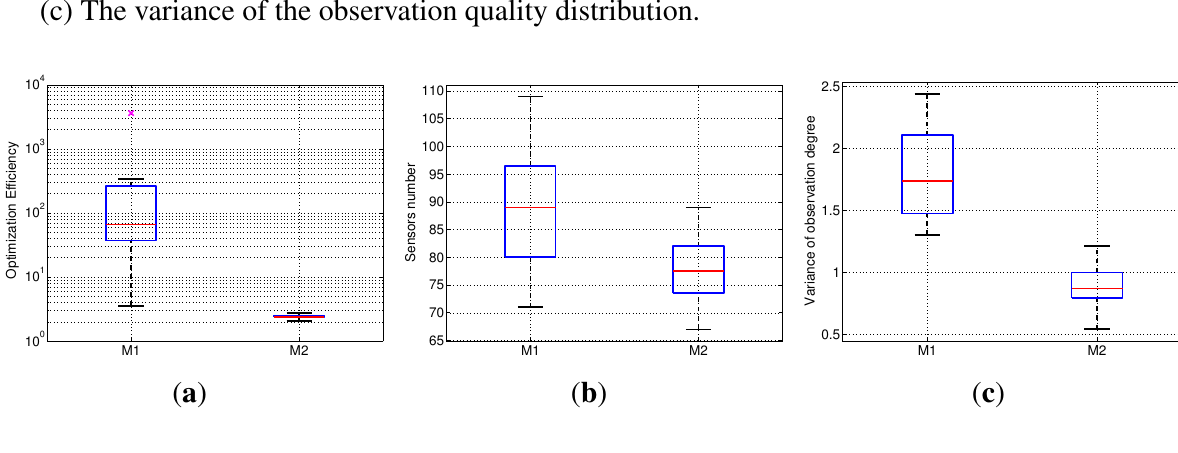
Figure 7. Comparison between the binary integer programming (BIP) objective function with the binary model and our objective function with the nonuniform model. (a) The optimization time for the two objective functions. (b) The number of deployed cameras. (c) The variance of the observation quality